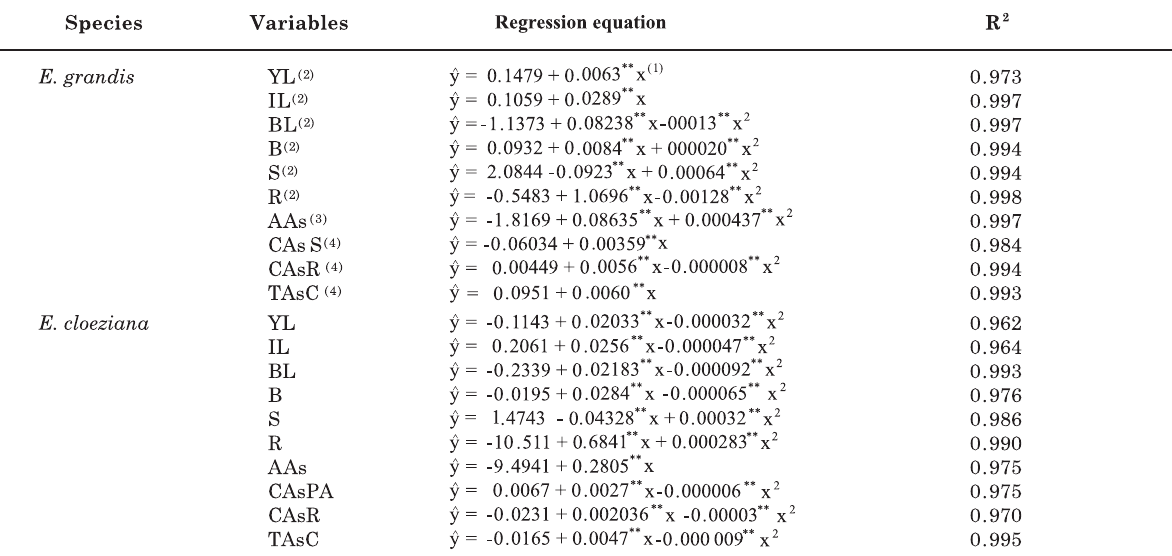
(p ≤ 0.01), adjusting to square root and quadratic models (Figure 4). The highest translocation index (TI) was obtained for E. cloeziana at a dose of 50 mg dm -3 (70.8 %). The reduction in TI with increasing As doses for this species appears to be due to tolerance Table 3. Regression equations for As concentrations in young leaves (YL), intermediate (IL), baseline (BL),